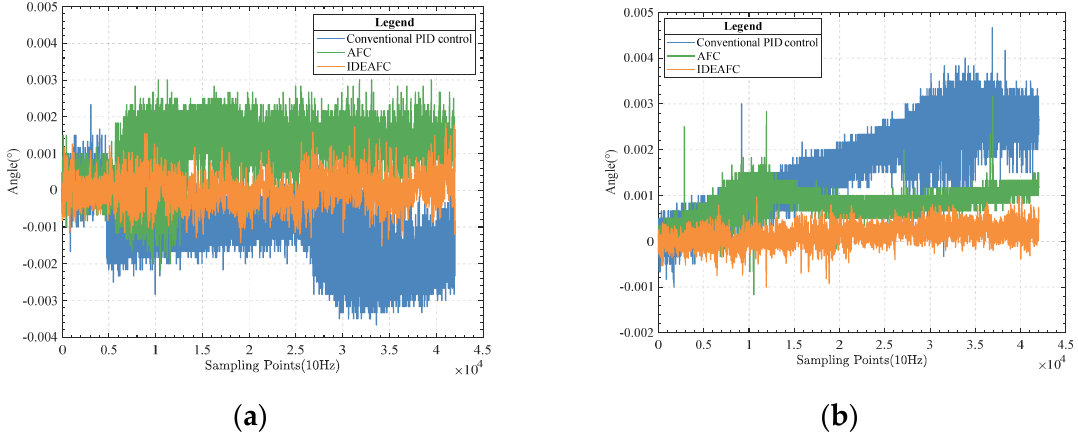
Figure 12. ( a ) Comparison of pitching angle data; ( b ) comparison of rolling angle data. The data collected by the electronic self-collimator and IMU were compared separately to study the relationship between the overall stability accuracy and control accuracy of the platform. Since the electronic self-collimator is a high-precision optical goniometer, its reflector is small and fixed, so it can only be used under static test conditions. The relationship between the platform’s overall stability and control accuracy were evaluated from the comparison experiment under static conditions, and then used to analyze whether the stability accuracy of various algorithms meets the requirements. In the static experiment, the pitch angle and the roll angle measured by the electronic self-collimator are shown in Figure 13.